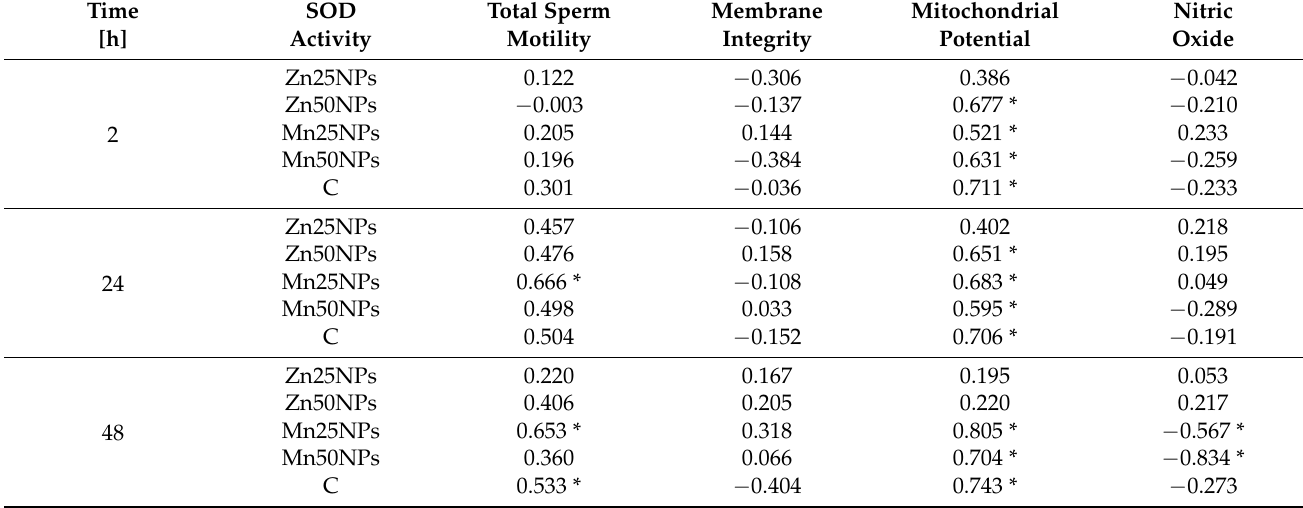
All correlations between SOD activity and the rest of examined parameters (Table 5), were described previously above the Tables 2–4. Table 5. Correlations between SOD activity and other sperm parameters during the preservation procedure. Time [h]